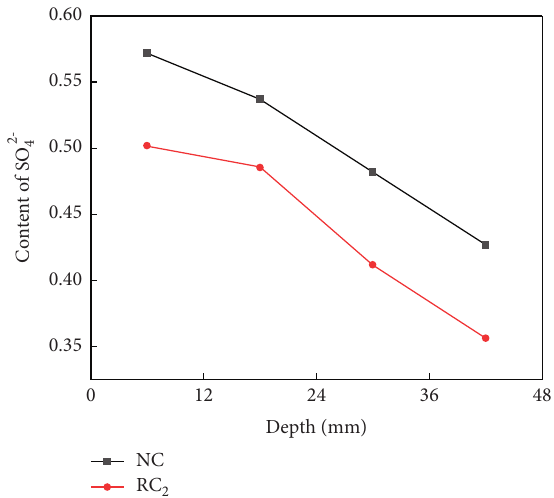
Figure 10: SO 42 − content of NC and RC when dry-wet cycle being 45 times.